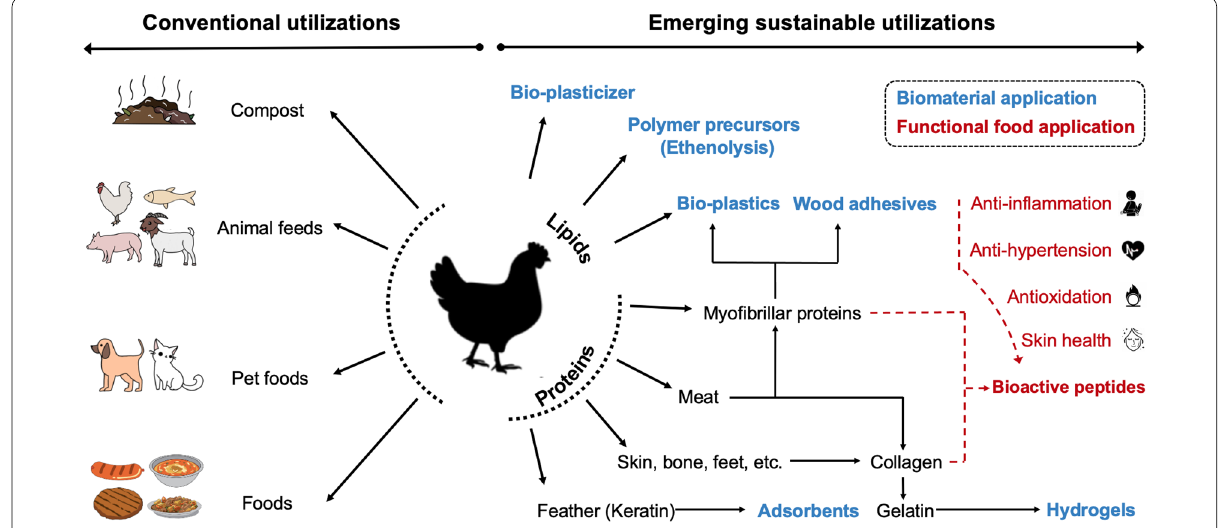
Fig. 3 Overview of conventional and valorized uses of spent